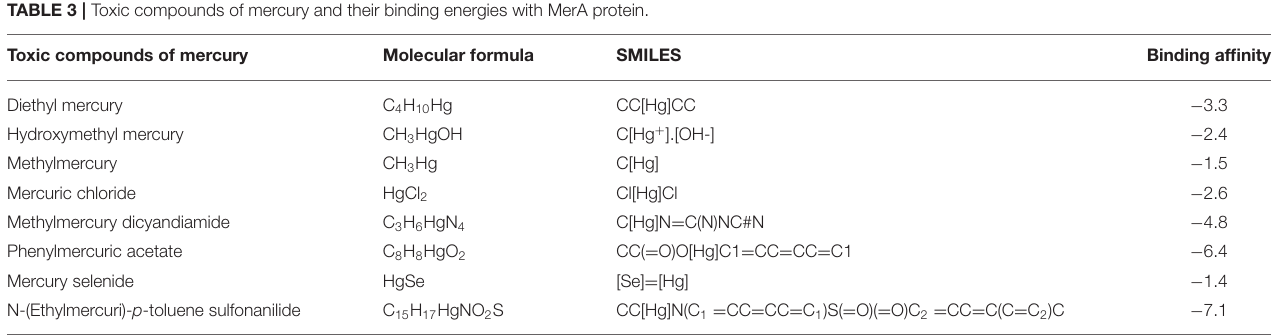
TABLE 3 | Toxic compounds of mercury and their binding energies with MerA protein. Toxic compounds of mercury Molecular